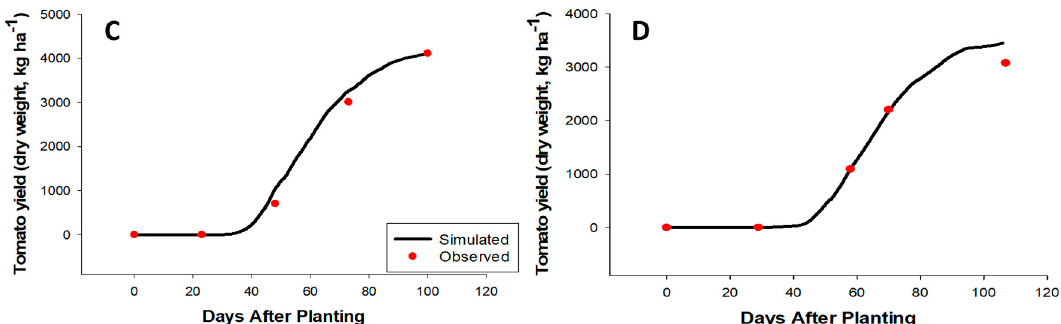
Figure 3. Results of the model calibration for fruit number during the fall 2016 ( A ) and spring 2017 ( B ) seasons and yield during the fall 2016 ( C ) and spring 2017 ( D ) seasons of drip-irrigated fresh-market tomato production in Immokalee, Florida.